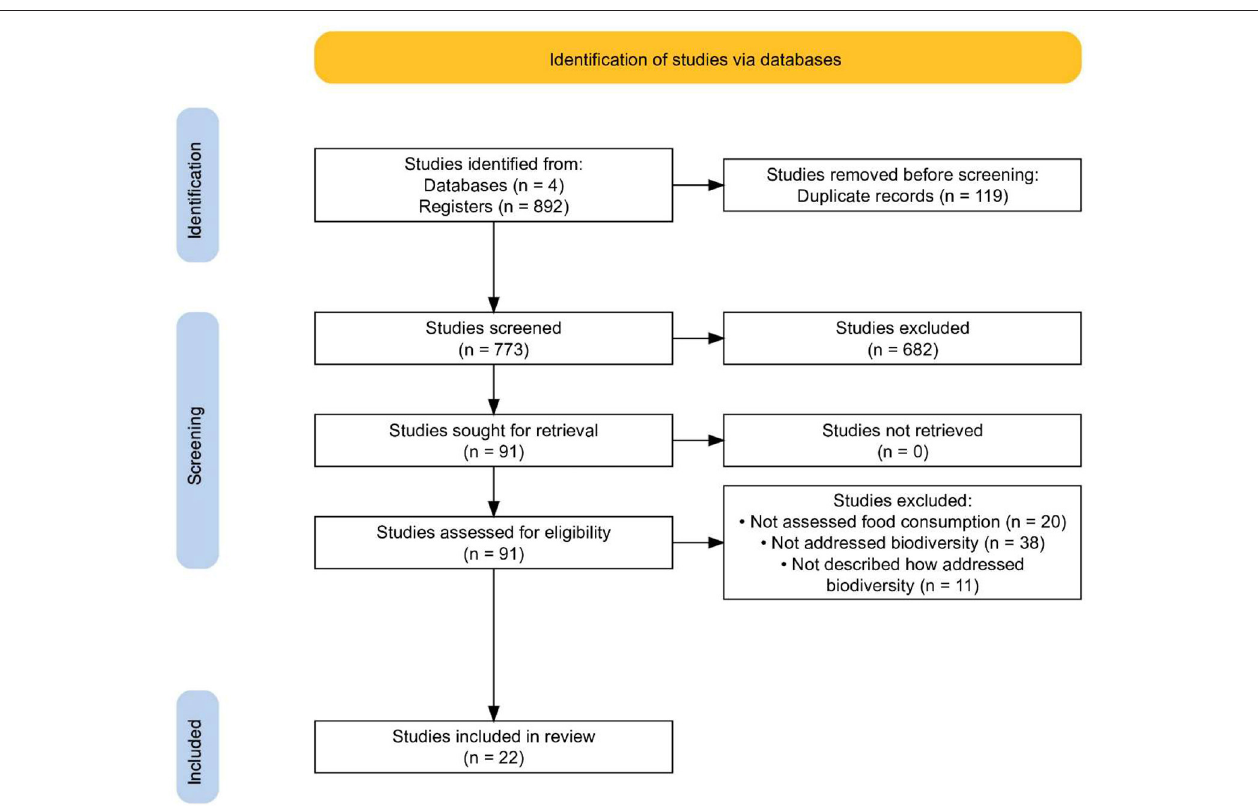
FIGURE 1 | Flowchart of the study selection